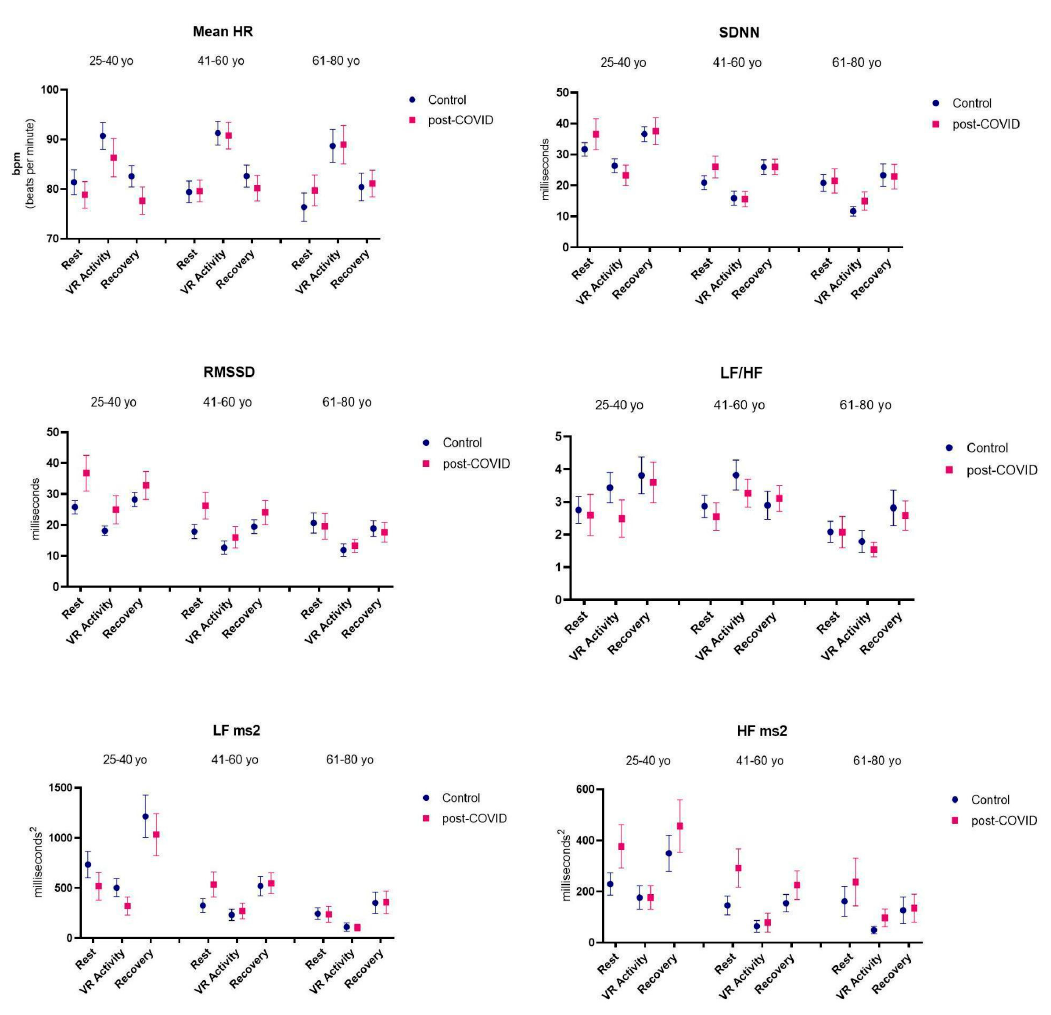
Figure 4. Representation of the mean and standard error of time and frequency domain indices of HRV between groups (Control and post-COVID), ages (25–49 yo, 41–60 yo, and 61–80 yo), and moments (Rest, VR activity, and Recovery). Yo: years-old; VR: Virtual Reality; HR: heart rate; RMSSD: Root-mean-square of the squared differences between successive RR intervals; SDNN: Standard deviation of the mean of all RR intervals over a period; HF: high frequency; LF: low frequency; LF/HF: low frequency and high frequency ratio; ms 2 : millisecond squared.